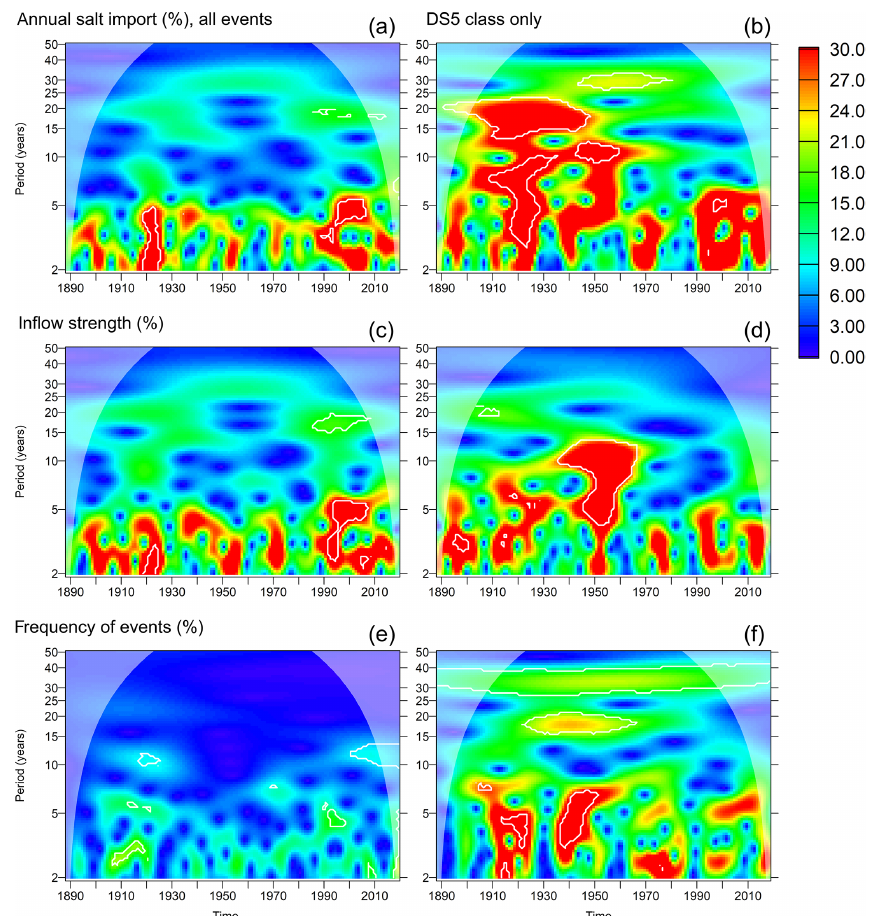
Figure 10. Wavelet analysis of the relative change in inflow activity (%). (a, b) total salt import. (c, d) Inflow strength as mean salt import during a single inflow event. (e, f) Inflow frequency as number of inflows per year.